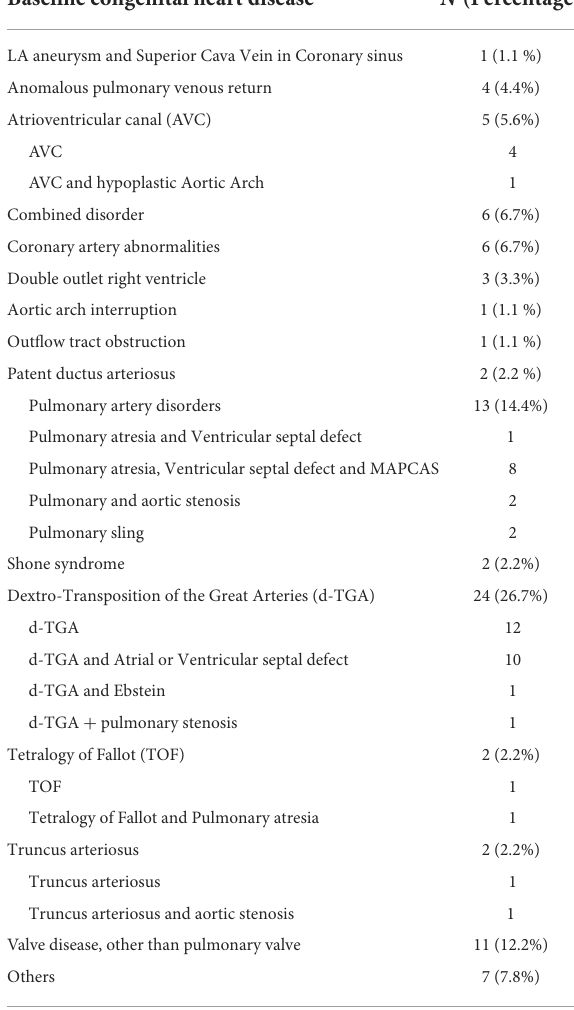
TABLE 1 Distribution of congenital heart